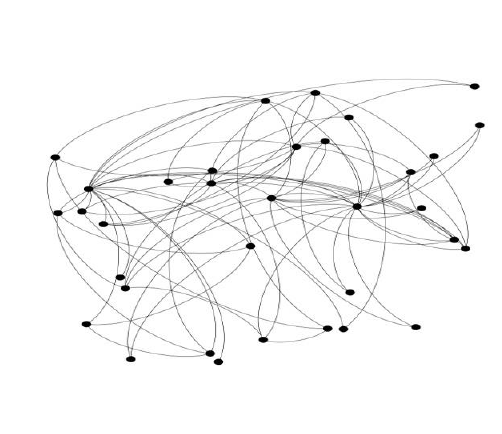
Figure 3. Zachary’s Karate Club.